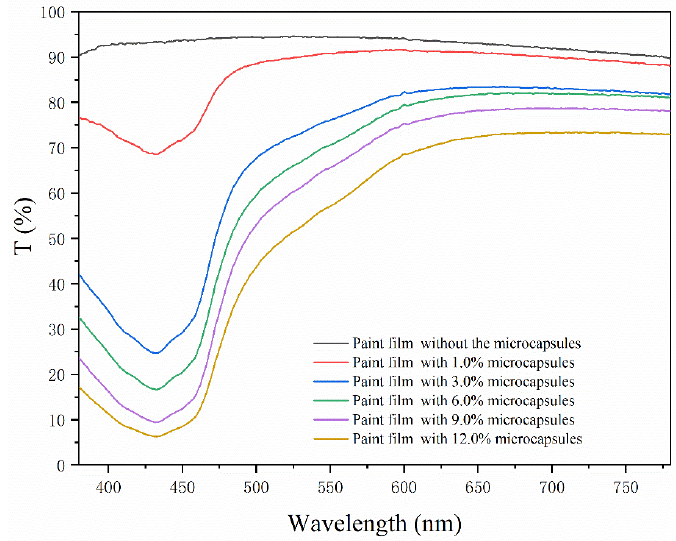
Figure 16. The trend of the transmittance of the paint films.